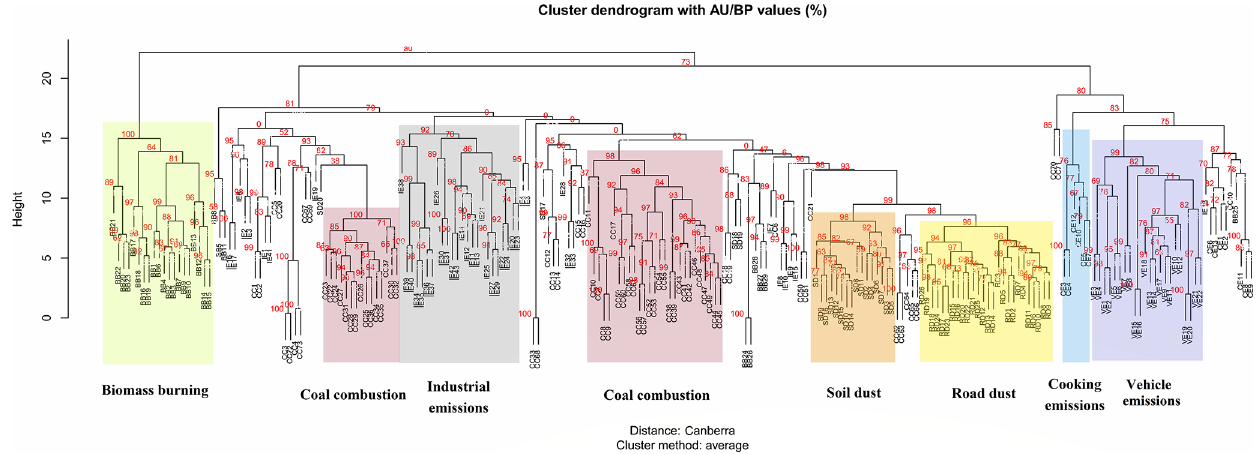
Figure 16. Result of the cluster analysis on the collated profiles. AU (approximated unbiased) p values are reported in red as percentages. BP refers to the bootstrap